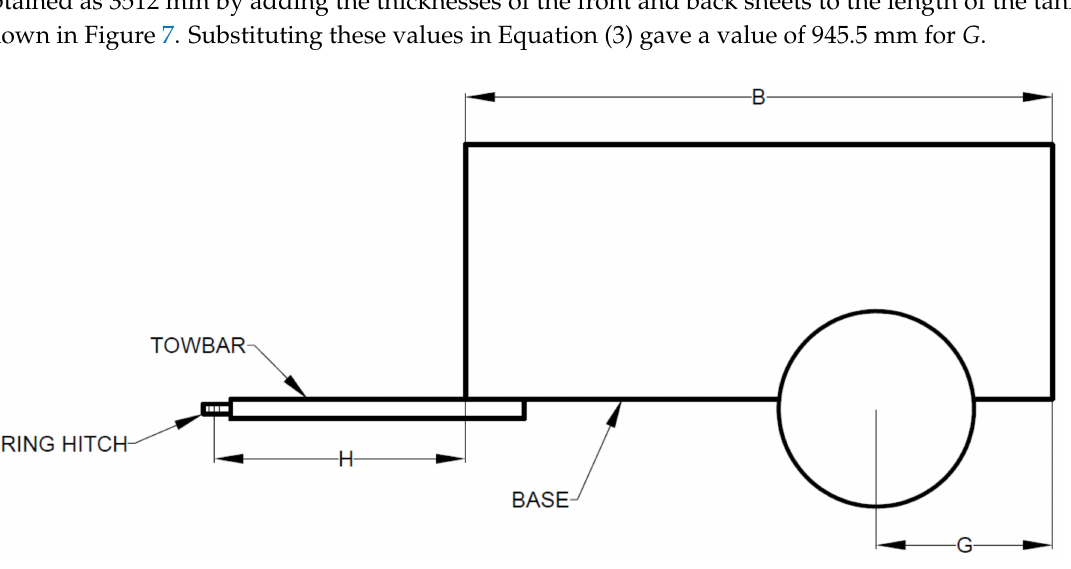
Figure 8. A single axle